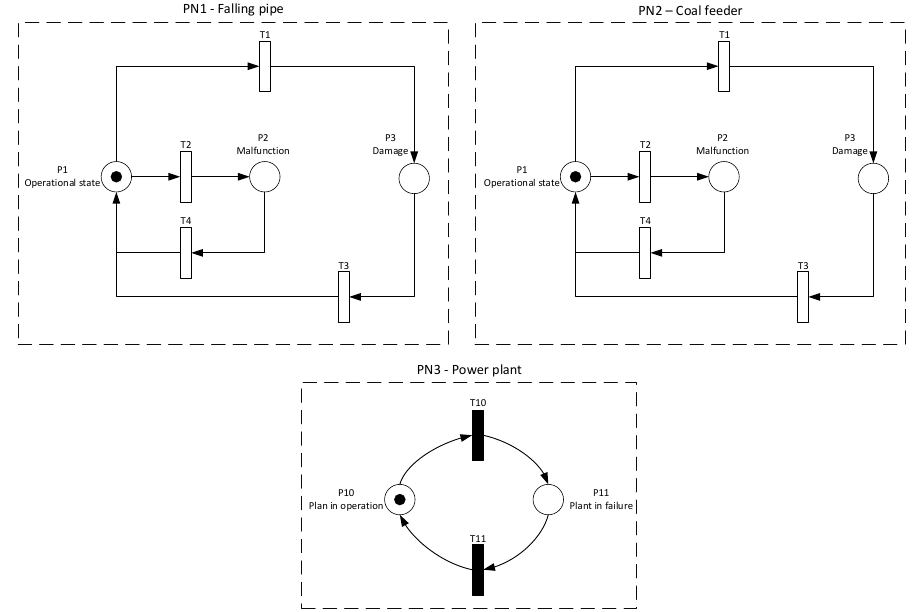
Figure 4. Proposed coal mill model is described with three Petri nets. The coal mill contains two components, the falling pipe and coal feeder, that are modeled with two GSPNs. The status of the coal mill is modeled using a Petri net with two states and immediate